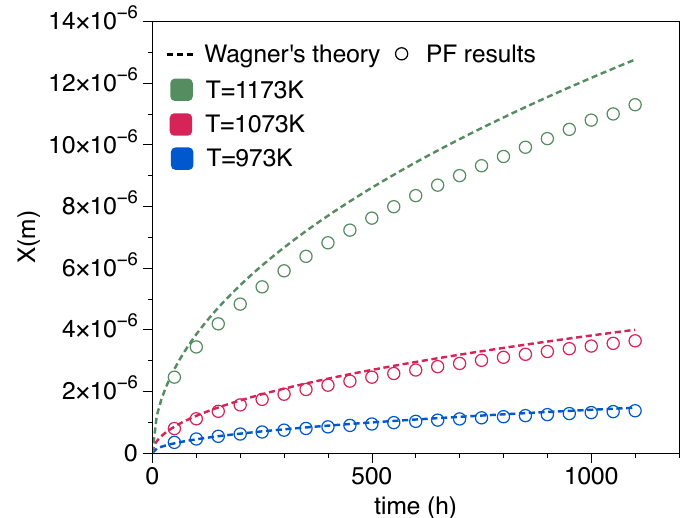
Figure 2. Comparison of the oxide scale thickness X of the Cr 2 O 3 layer obtained from PF results and the predictions of Wagner’s theory for different temperatures, such as T = 1173 K, 1073 K and 973 K = 0.05. The increment of temperature significantly enhances the in an Fe-22 wt.%Cr alloy with N 0 O growth velocity of Cr 2 O 3 .